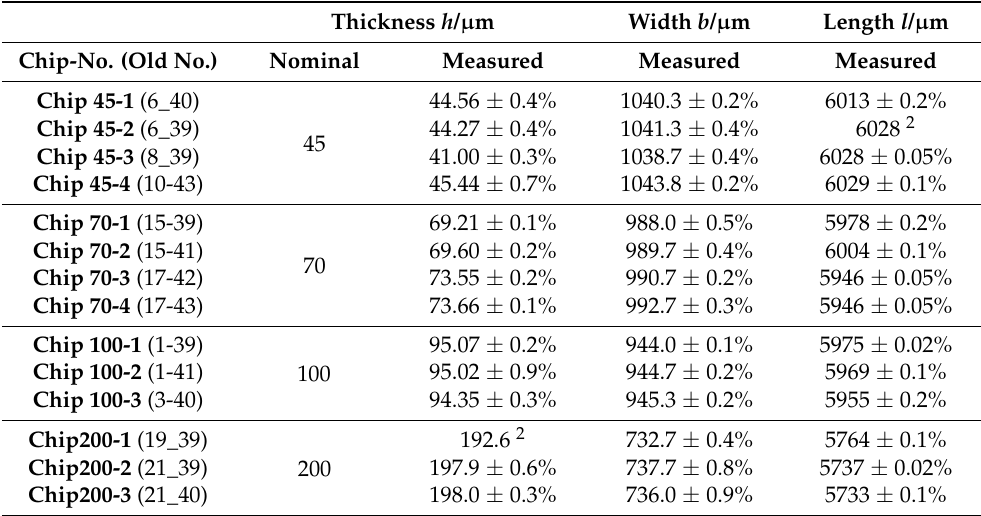
Table 2. Geometrical dimensions of several cantilevers 1 . Thickness h / µ m Width b / µ m Length l / µ m Chip-No. (Old